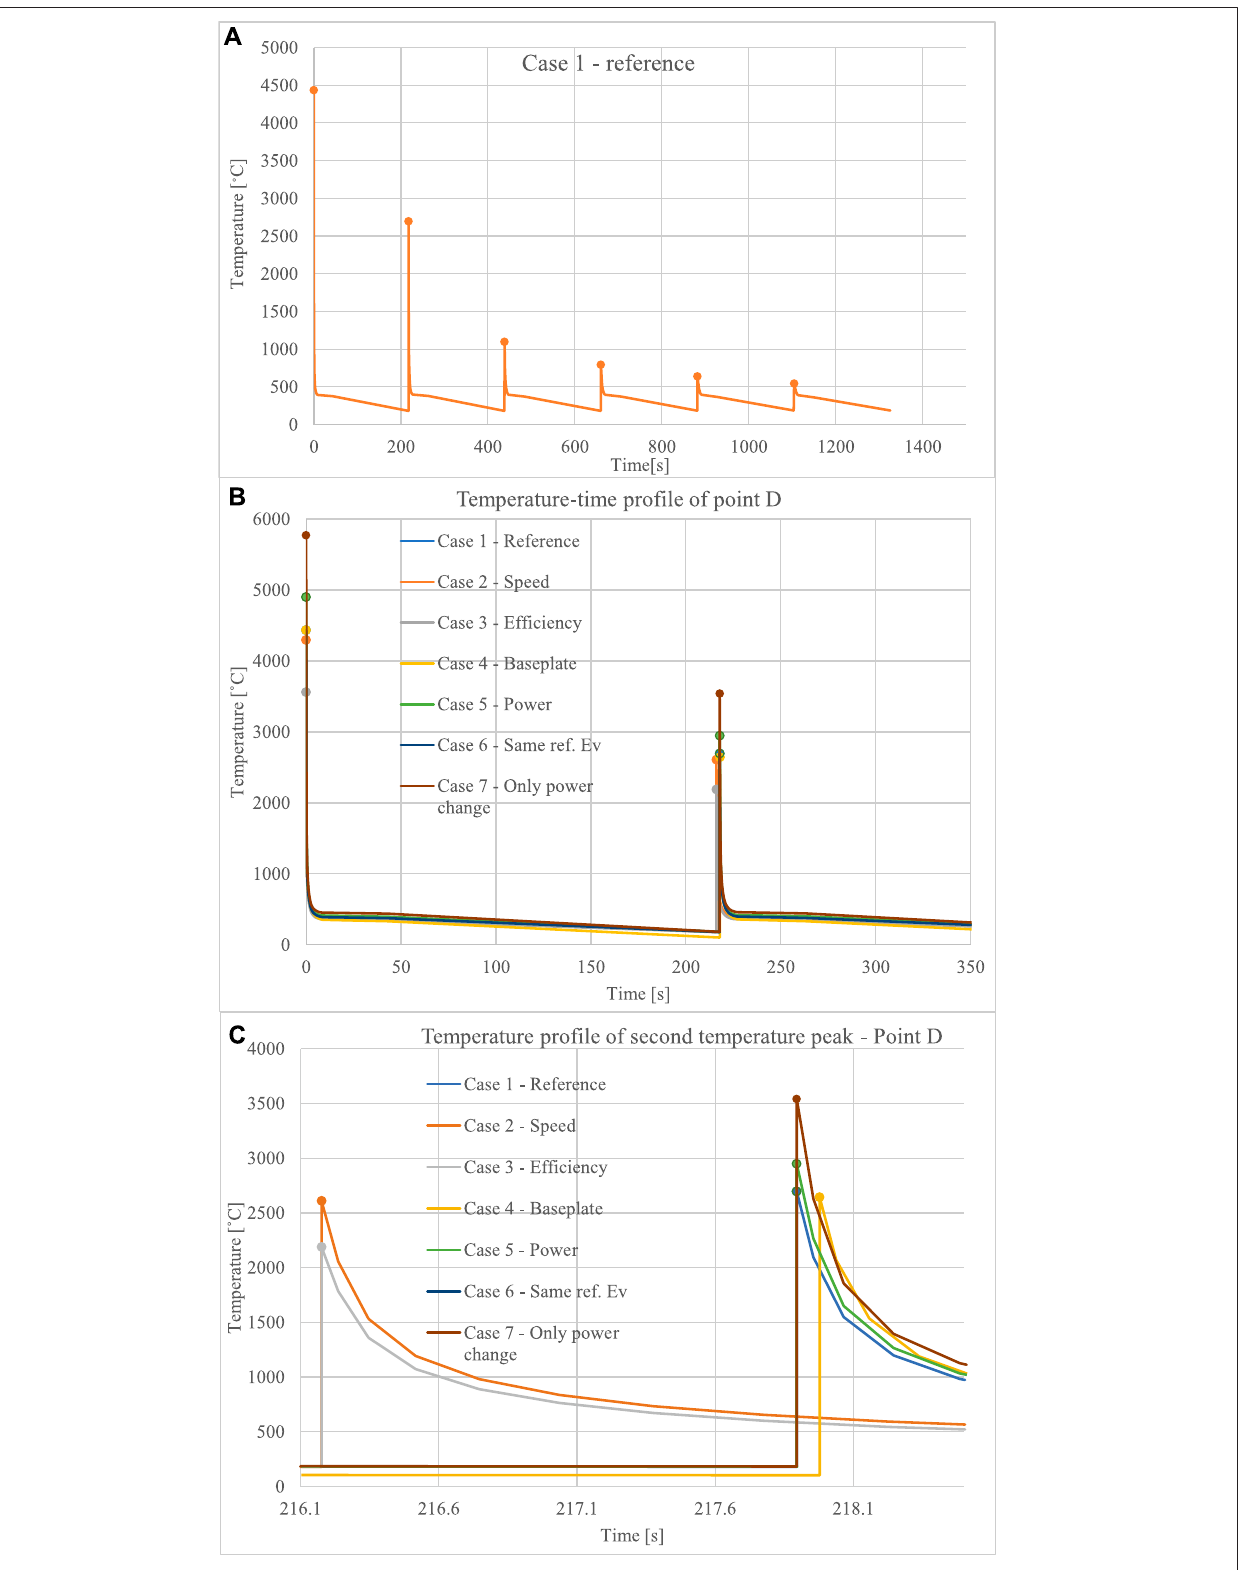
FIGURE 3 | Temperature – time pro fi les at the bottom of the part (point D) using different sets of build parameters for (A) the fi rst 1300 s/six temperature peaks for Case 1, (B) the two fi rst scans leading to melting and solidi fi cation, and (C) the second scan leading to melting and solidi fi cation for all cases .